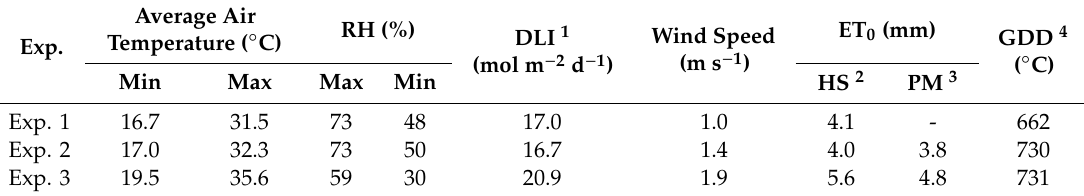
Table 1. Main climatic features during the experiments.